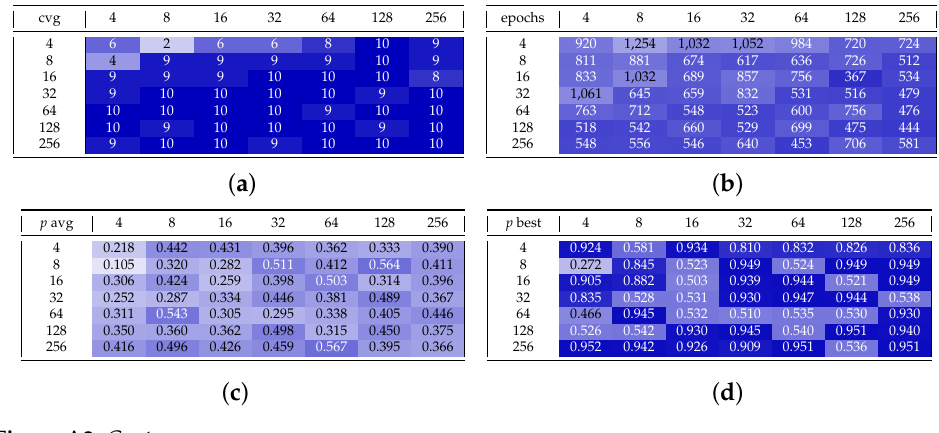
(c) p -value for the χ 2 test once convergence is reached (average over converging runs). Figure A2. Cont